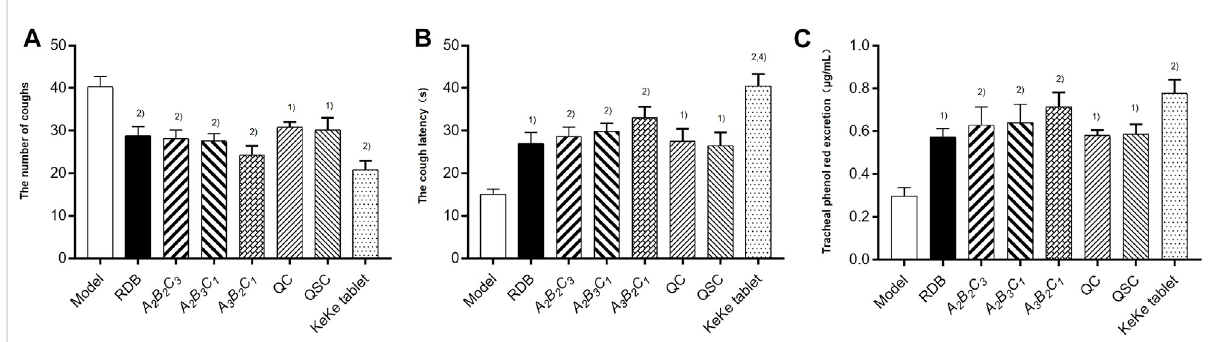
FIGURE 6 Processing with ASR conserved the antitussive and expectorant ef fi cacy of RDB in mice. (A) The number of coughs. (B) The cough latency. (C) Tracheal phenol red excretion. Data were expressed as mean ± S.E.M., with 10 mice in each group. 1) p < 0.05, 2) p < 0.01, compared with the Model group, 3) p < 0.05, 4) p < 0.01, compared with the RDB group, 5) p < 0.05, 6) p < 0.01, compared with the A 3 B 2 C 1